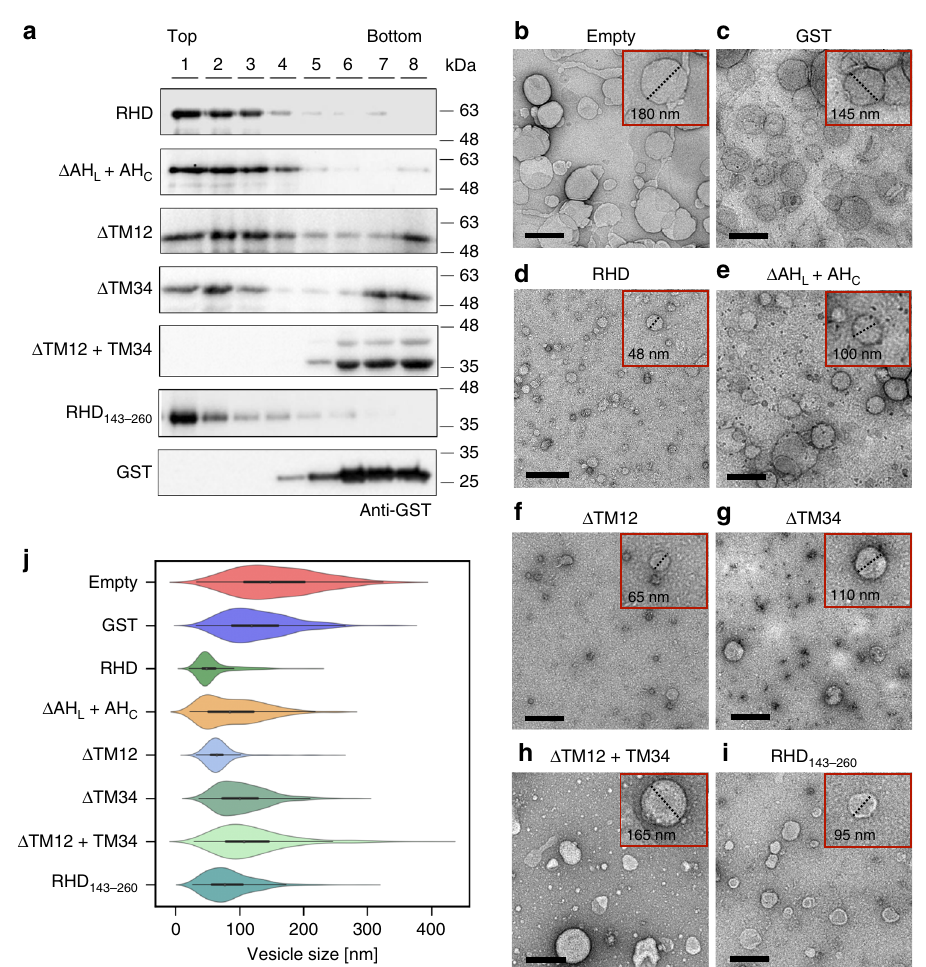
Fig. 6 RHD structure determines in vitro membrane binding and liposome remodeling activity. a Liposome co- fl otation assay to evaluate membrane- binding properties of FAM134B-RHD and various deletion mutants (see the section “ Methods ” ). Puri fi ed protein samples were incubated with liposomes for 2 h at 37 °C and subjected to fl otation on a sucrose cushion (top to bottom, 1 – 8) followed by SDS – PAGE and western blotting with anti-GST antibody. b – i Representative nsTEM micrographs of remodeled proteoliposomes (scale bars, 200 nm). Empty liposomes ( b ) were remodeled by incubation after addition of puri fi ed ( c ) GST, ( d ) wild-type RHD, ( e ) Δ AH L + AH C , ( f ) Δ TM12, ( g ) Δ TM34, ( h ) Δ TM12 + TM34, and ( i ) RHD 143 – 260 for 18 h at 22 °C. Insets (red squares); magni fi ed micrographs showing examples of representative proteoliposomes with diameters measured (dotted lines) using ImageJ. j Violin plots show the measured proteoliposome size-distributions ( n = 300 each) from nsTEM images. Violins shows a central boxplot (median with interquartile range, black lines) along with mirrored histograms on either sides